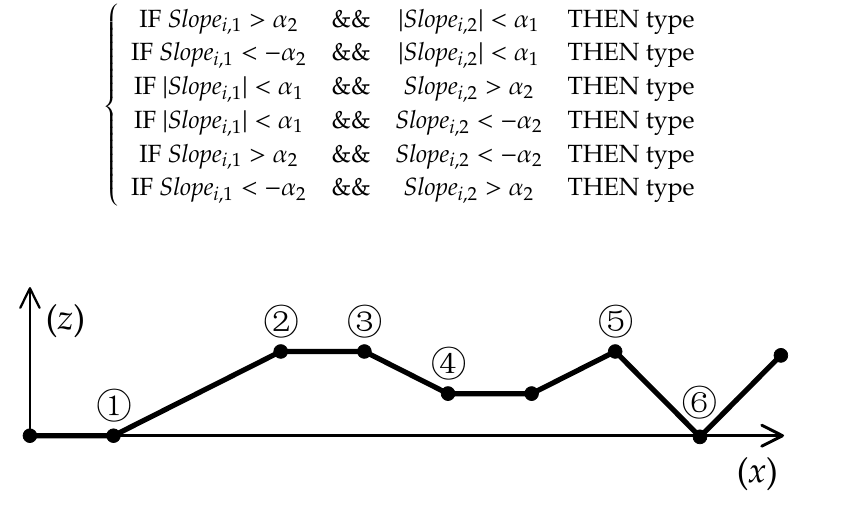
Figure 8. Height changes along a road topographic